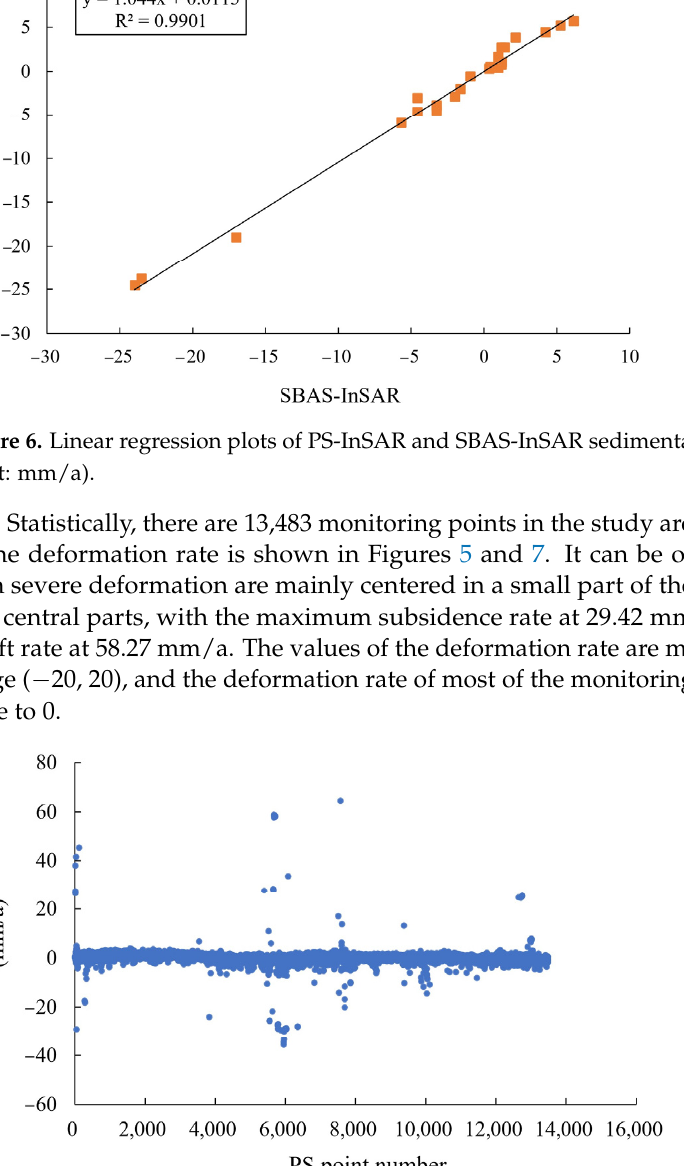
Figure 8. Histogram of deformation rate range (Unit: mm/a). Figure 9 shows the distribution of the cumulative deformation value of the ground points, and Figure 10 statistically shows the distribution ranges of the cumulative defor- mation of the ground points. As can be seen from the figures in the study area, the maxi- mum cumulative subsidence reaches 96.27 mm, and the maximum cumulative uplift reaches 199.64 mm; the cumulative deformation in most of the areas shows subsidence, and only some areas in the north and central parts show uplift. The cumulative defor- mation range with the largest number of ground points is ( − 30, 5), and the number of ground points accounts for about 76% of the total; the second is the range (5, 35), and the number of ground points accounts for about 24% of the total.